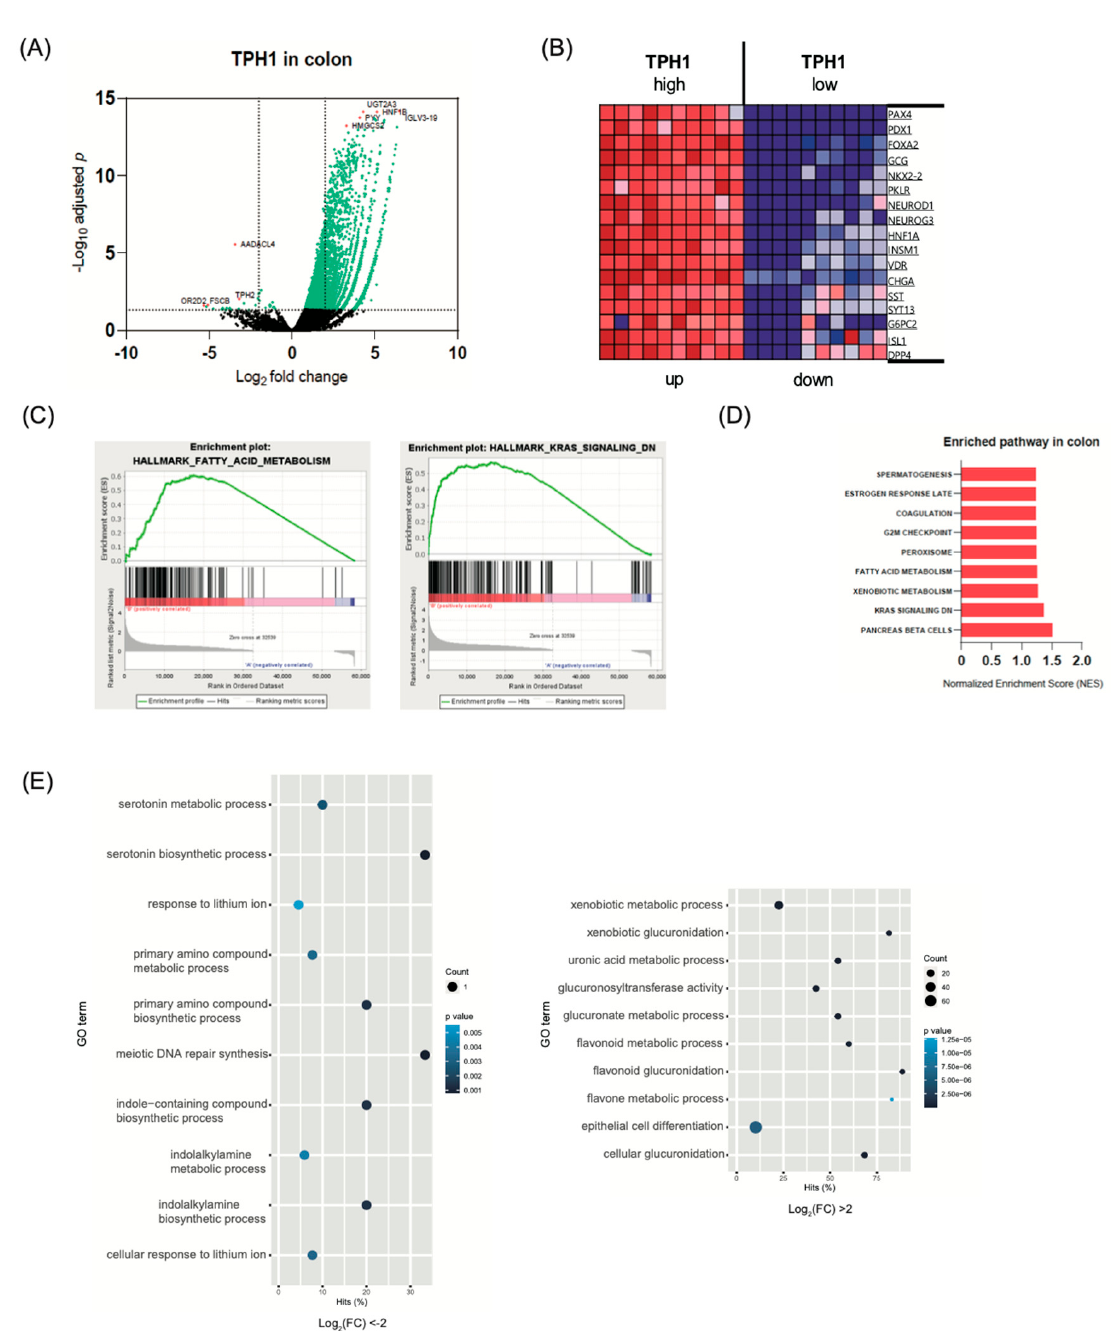
Figure 3. Gene expression changes in colon according to TPH1 expression ( n = 10 per group). ( A ) Volcano plot of the significantly differentially expressed genes (DEGs). ( B ) Heatmap of DEGs. ( C – E ) DEGs were analyzed by Gene set enrichment analysis. ( C ) The enrichment plot for fatty acid metabolism and K-RAS signaling. ( D ) Bar plot depicting the normalized enrichment scores (NES). ( E ) Dot plot for enriched gene ontology pathways from GSEA